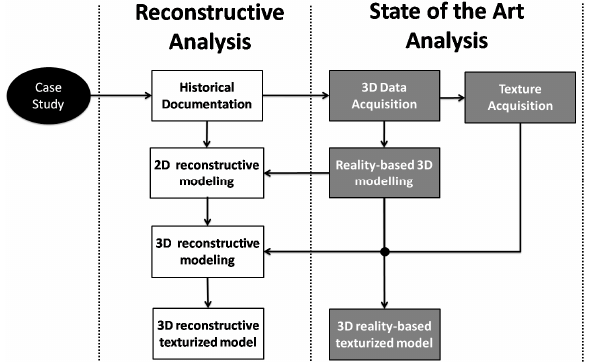
Figure 8. Block diagram of the reconstruction process based